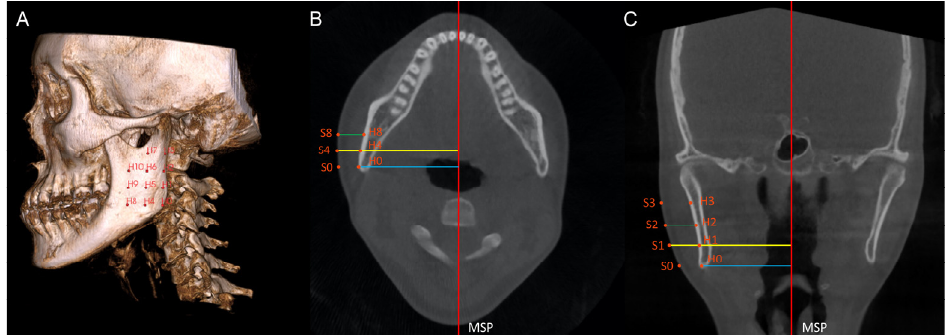
Figure 2. ( A ) Hard tissue points H0 to H10 are shown on the ramus. ( B , C ) Hard tissue points and the corresponding soft tissue points are identified on the axial ( B ) and coronal ( C ) slices. The axial and coronal slices show the measurement of hard tissue prominence (blue line), soft tissue prominence (yellow line), and soft tissue thickness (green line). MSP, mid-sagittal